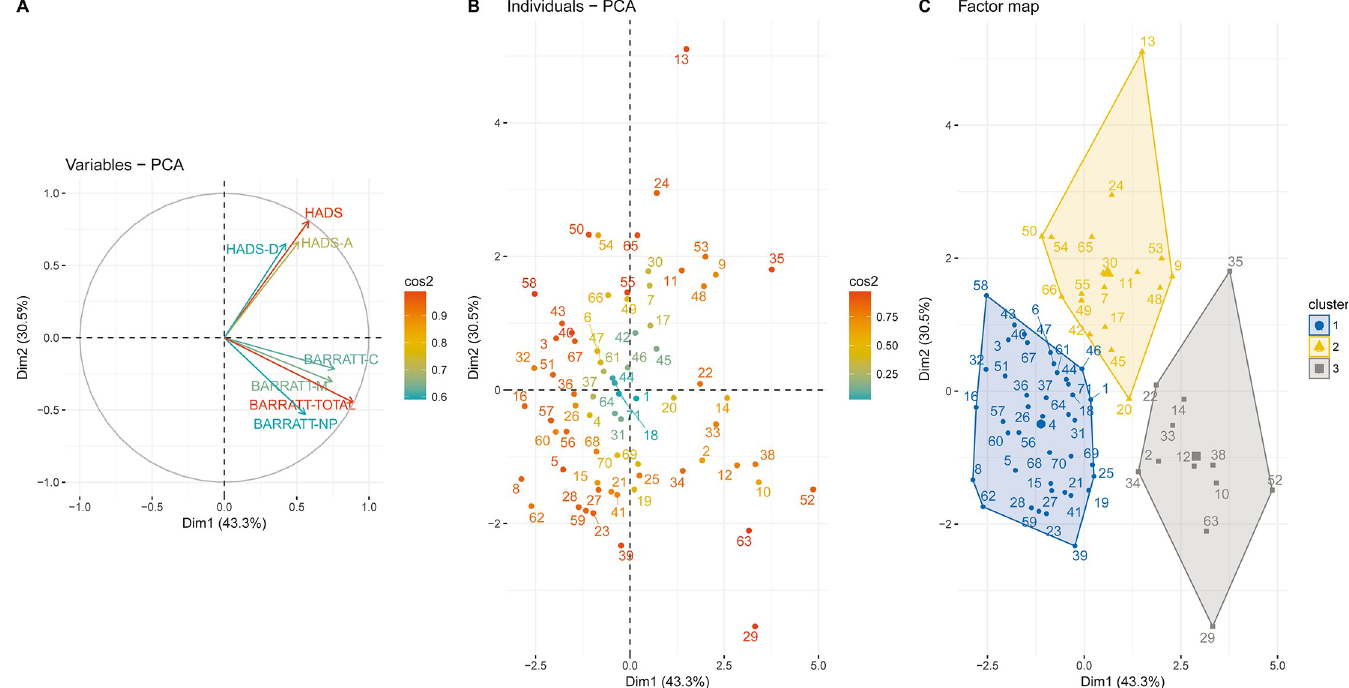
Fig 1. Principal Component Analysis (PCA) of the HADS and BIS-10 scores of 71 LCH patients. Loading plots of the first two components are shown: the first component is on the horizontal axis, and the second component is on the vertical axis. (A) Plots of the HADS and BIS-10 variables. (B) Plots of patients. (C) Clusters identified among the study population through hierarchical clustering